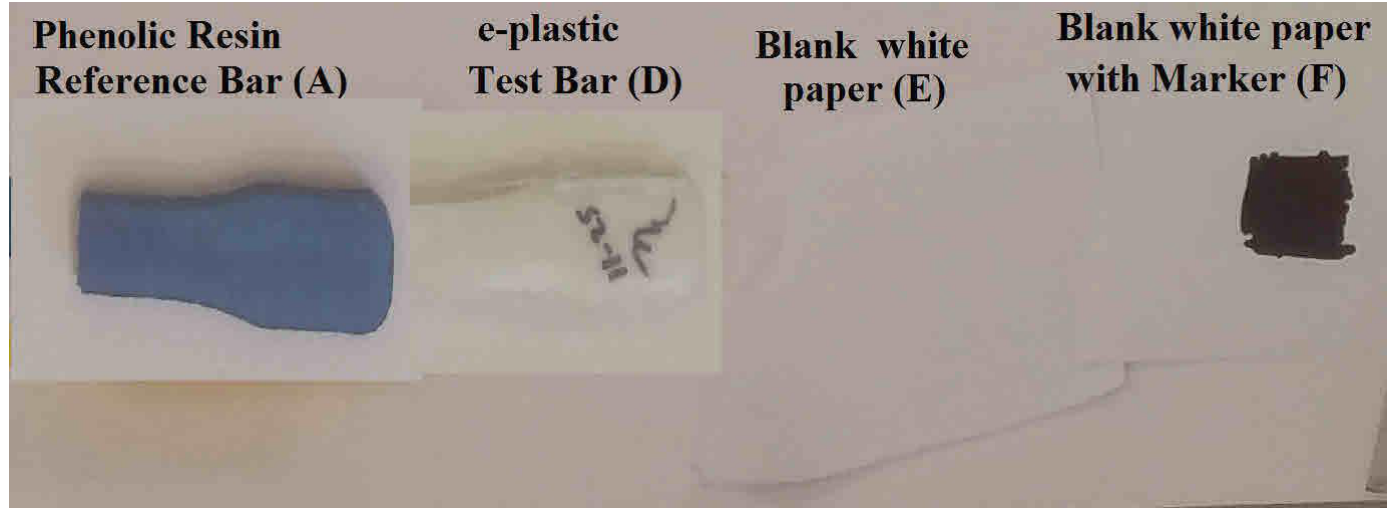
Figure 5. E-plastics samples ( A–F ) analyzed by hand-held XRF (see Tables 1 and S1).